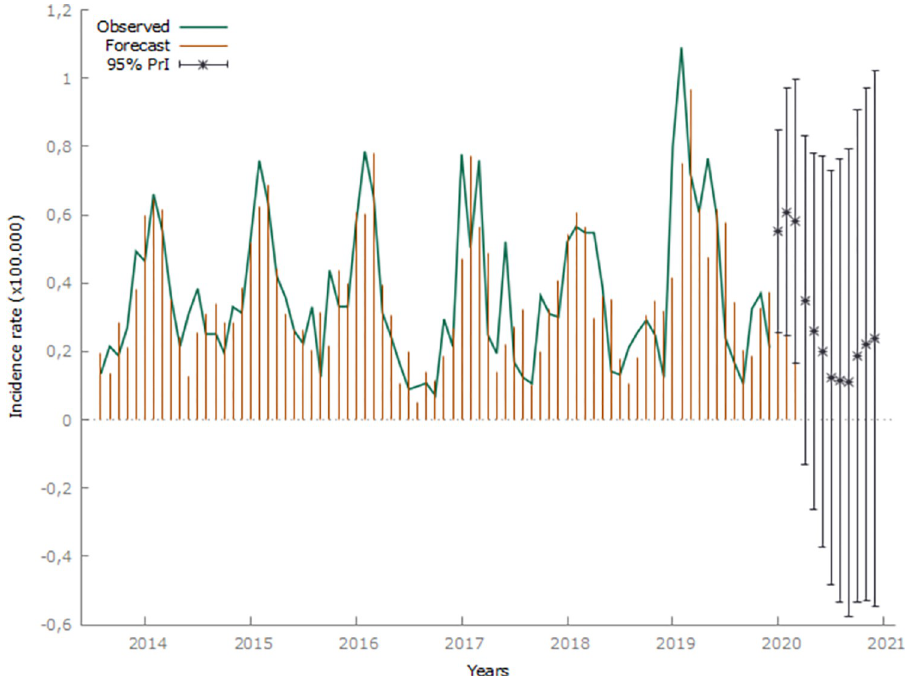
Fig 5. Monthly leptospirosis incidence time series distribution in Rio Grande do Sulbased on data from 2007 to 2019 and predicted values for 2020, with a 95% prediction interval (95% PrI), after Seasonal Autoregressive Integrated Moving Average (SARIMA) model